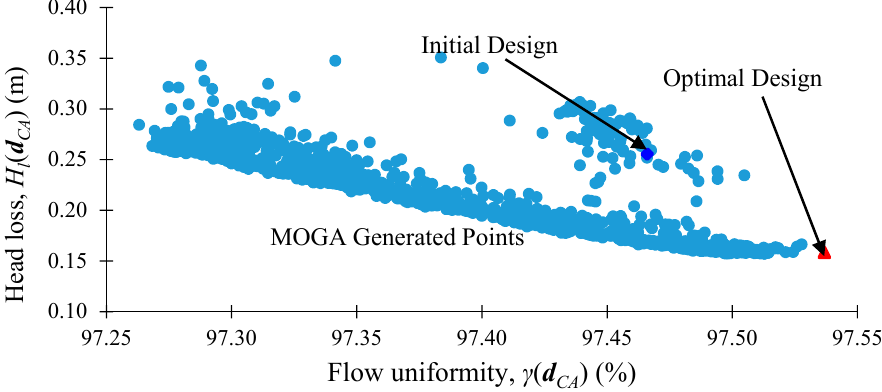
Figure 9. Pareto front for the optimization results of casing design.